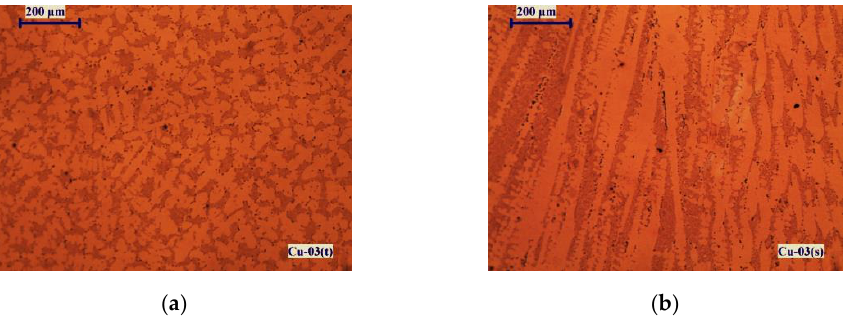
Figure 7. Macrostructures of sample Cu-02 obtained at T = 1500 K for τ = 15 min: ( a ) from the top of the ingot; ( b ) from the transverse section.